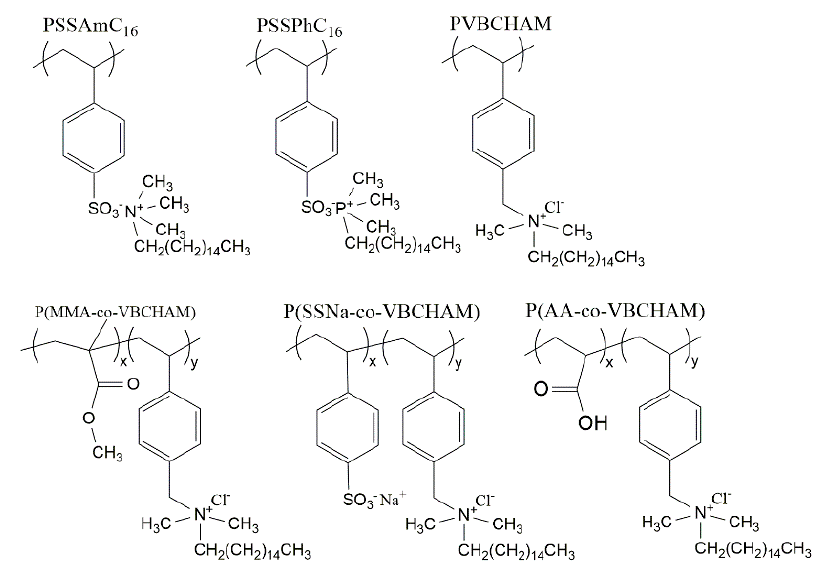
Figure 4. Chemical structure of the homopolymers PSSAmC 16 , PSSPhC 16 , PVBCHAM and the copolymers P(MMA- co -VBCHAM), P(SSNa- co -VBCHAM) and P(AA- co -VBCHAM) [129]. Materials 2016 , 9 , 599 12 of 32